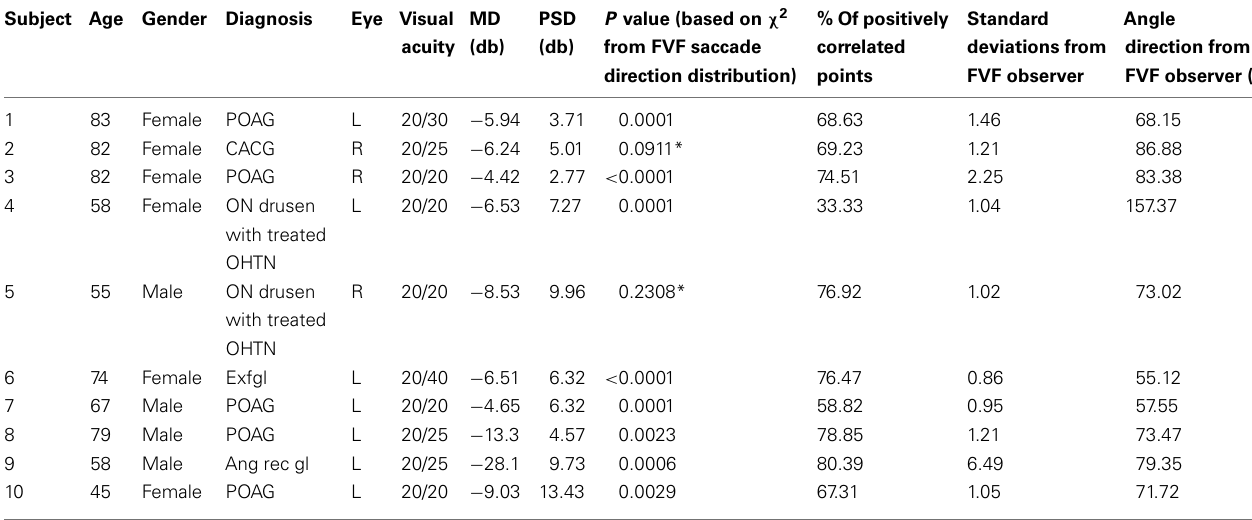
Table 1 | Peripheral visual field loss patient information and